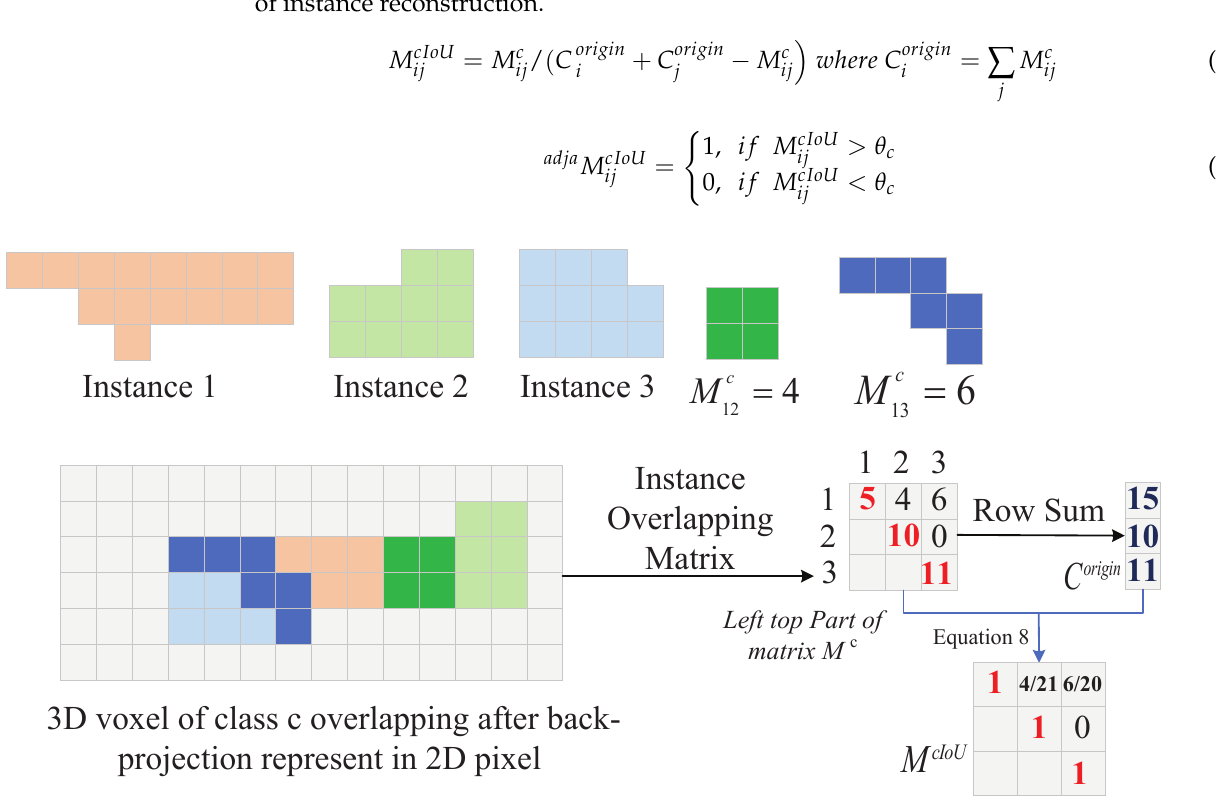
Figure 7. Instances fusion illustration in one class. (Note: There are three instance examples in color orange, light green, and light blue. We present their overlapping in 2D grid, the green grid represent the overlapping between instance 1 and instance 2, the blue grid represent the overlapping between instance 1 and instance 3. The number of green and blue grids are 4 and 6 which are converted to overlapping matrix element M c and M c . Instance 2 and instance 3 are not overlapping which 12 13 = 0. The diagonal of M c represent residual instance voxels of smaller instance after leads to M c 23 = 5). Row sum up can obtain each instance original being overlapped by bigger instances (e.g., M c 11 number, and by using Equation (8), we can calculate the IoU matrix for class c